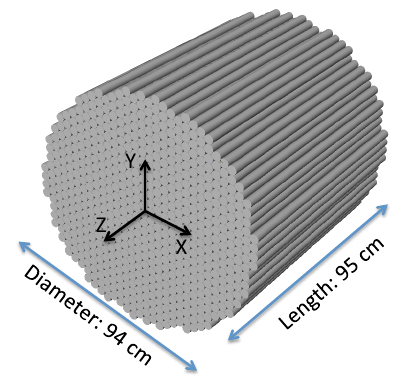
Figure 11. Representation of the active volume of the ALADInO calorimeter. 15925 LYSO crystals are arranged in a total assembly of 637 lines, each made of 25 aligned hexagonal prism crystals. Figure readapted from[96] under license CC BY 4.0.